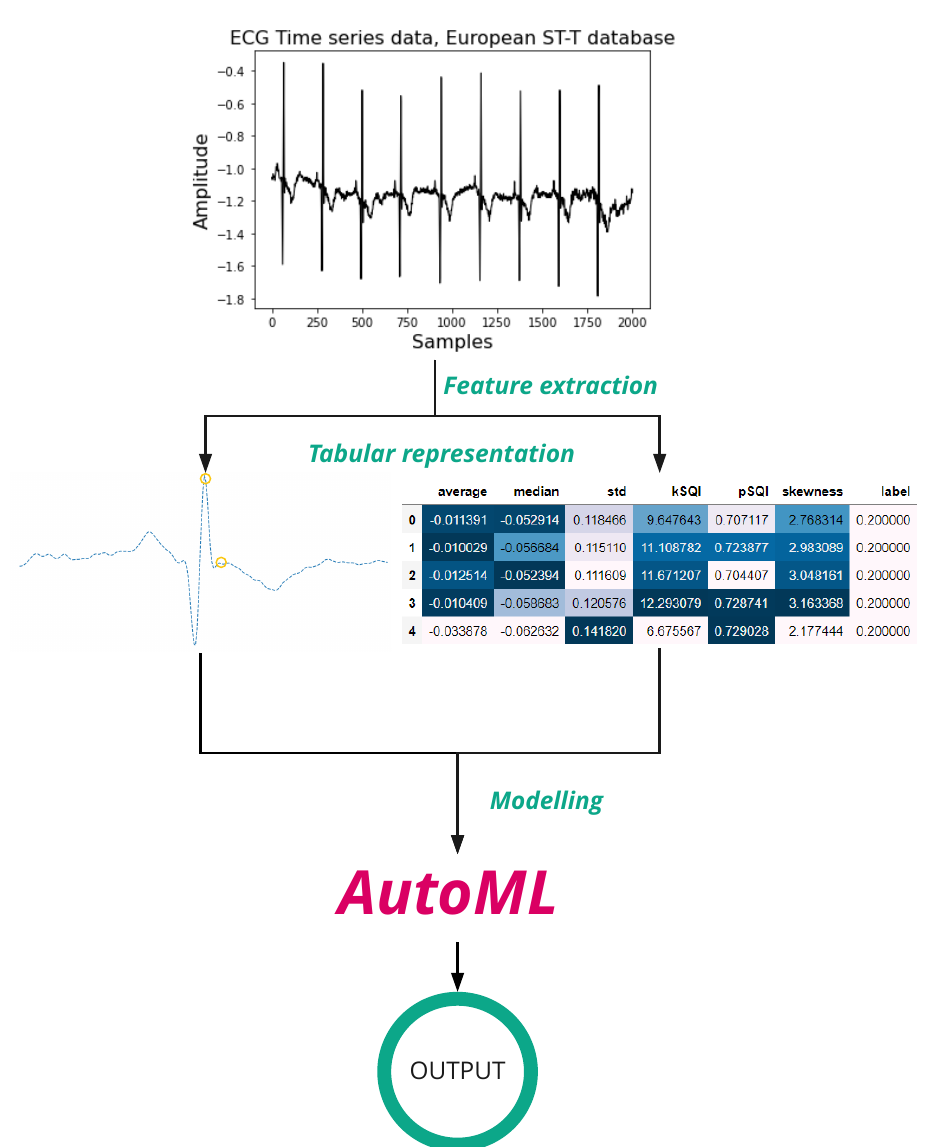
Figure 3. Overview of the process to the identification of ST-segment